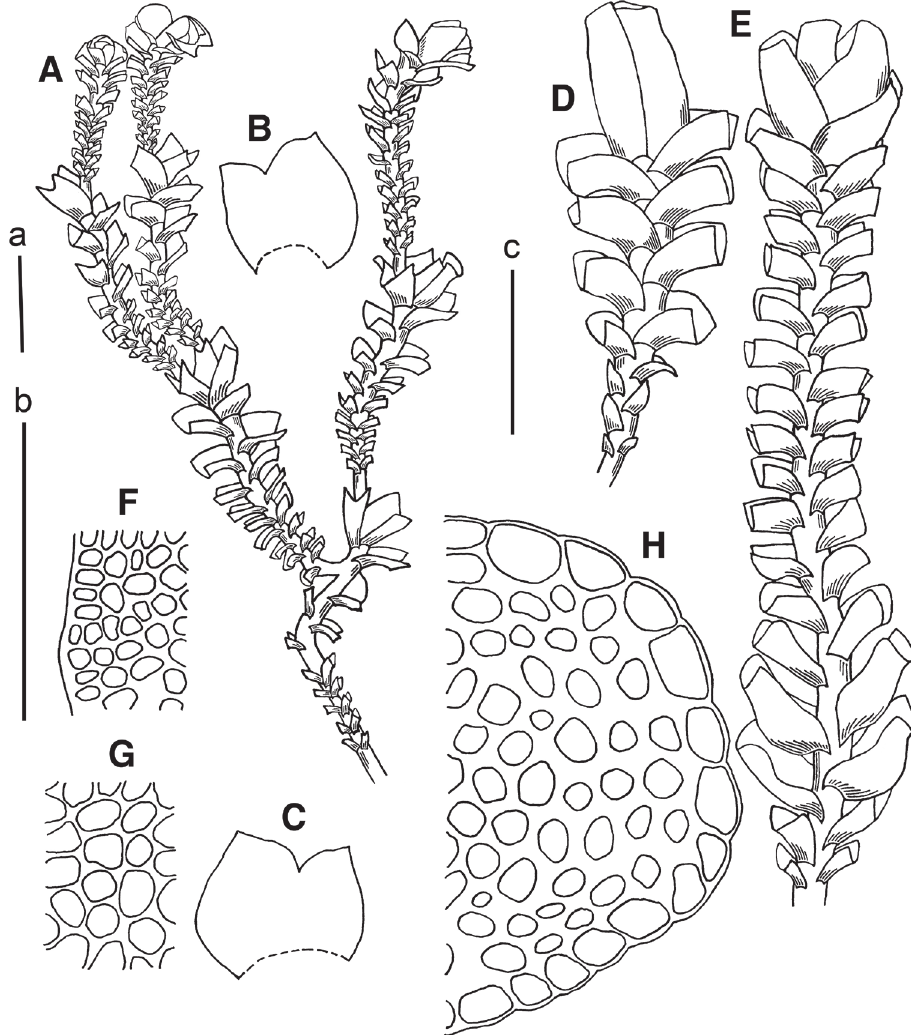
Figure 4. Marsupella pseudofunckii S.Hatt. A plant habit B, C leaves D female plant (fragment) E male plant (fragment) F cells along leaf margin G midleaf cells H stem cross section. Scale bars: a 1 mm ( A ); b 100 μm ( F–H ); c 1 mm ( B–E ). All from Choi 545 unequally thickened (but external wall thin), 12.0–25.0 μm along margin, trigones moderate, concave, scleroderm cells 10.0–13.0 μm in diameter, with strongly thick- ened walls and moderate in size, concave trigones, gradually transformed to inner tissue, cells in inner part 10.0–18.0 μm in diameter, walls thickened to almost thin, trigones moderate, concave. Leaves transversely inserted, not or barely sheathing stem in base, obliquely spreading, transversely oriented, evidently keeled-conduplicate with plane margin, keel straight to slightly arched or suddenly turned downward near the